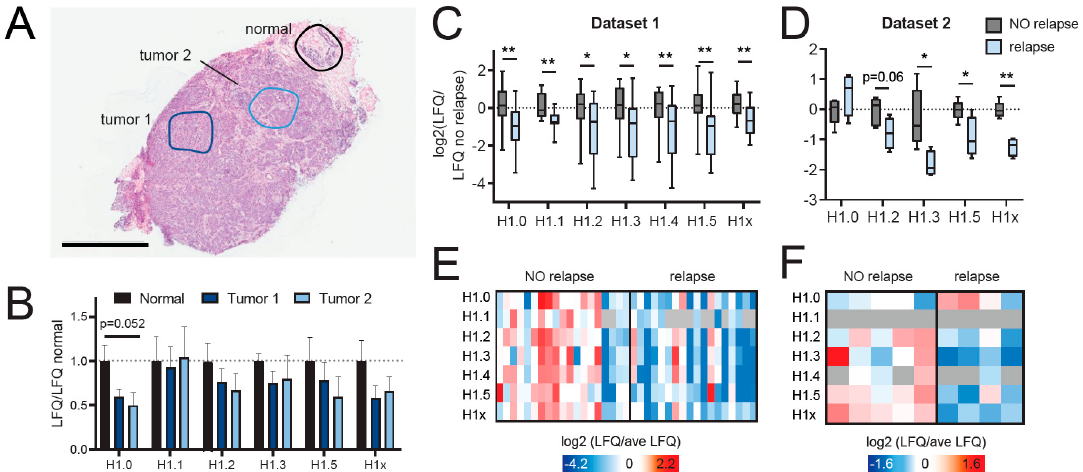
Figure 5. Quantification of histone H1 variants from patient samples. ( A ) Haematoxylin and eosin (H&E) staining of a breast cancer section. Normal epithelial cells and tumor cells (areas containing 1800–4500 cells from four consecutive sections) in the indicated areas were collected by laser micro-dissection (LMD) and analyzed by MS. Scale bar: 2 mm. ( B ) MS analysis of histone H1 variants from the tissue areas highlighted in ( A ). The histograms show the log2 of the LFQ fold-change relative to the average of the normal samples for each histone H1 variant. Error bars represent the standard error of the mean (SEM) from 4 laser micro-dissected areas. Tumor areas were compared to normal areas by one-way ANOVA, followed by Dunnett’s multiple comparison test. ( C,D ) Boxplot representation of the H1 variant LFQ values in triple-negative breast cancer samples with or without relapse three years after chemotherapy. The samples in ( C ) were stored in OCT, and whole slices were processed using the procedure described in Figure 1, while the samples in ( D ) were stored as FFPE tissues and whole proteomes where acquired. * p value < 0.05, ** p value < 0.01 by multiple t-test comparison. ( E,F ) Heatmap display of histone H1 variant levels for the samples described in ( C,D ), respectively. Log2 transformed MaxLFQ values, normalized over the average value across the samples are shown. The grey color indicates those variants that were not quantified.